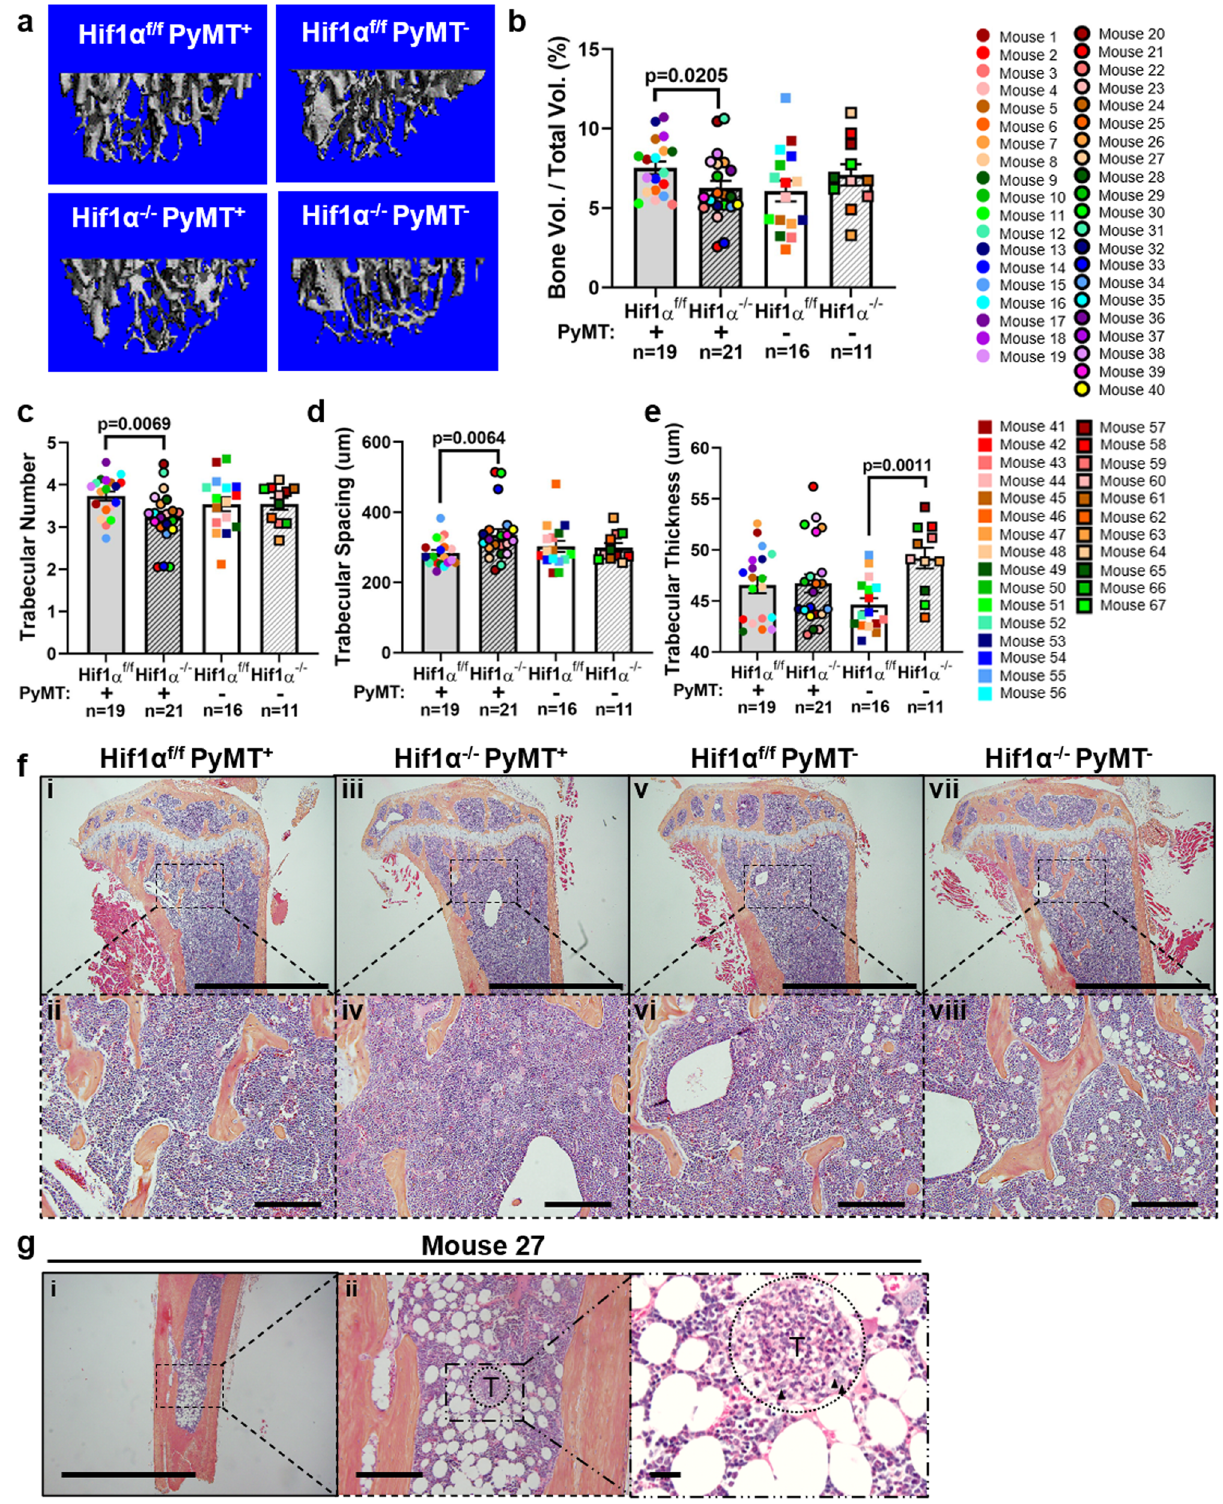
mice (Supplementary Fig. 5e) and no difference in Hif1 α tran- script levels (Supplementary Fig. 5f). Hif2 α deletion did not sig- ni fi cantly reduce Vegfa expression in the primary tumor (Supplementary Fig.